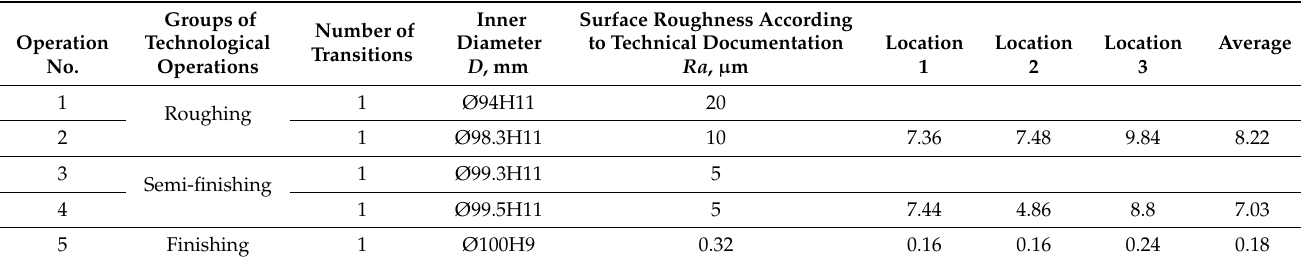
Table 3. Structure of technological operations for manufacturing hydrocylinder liners shown on an example of the KS- 4574.63.900 hydrocylinder for releasing the KTA-25 truck crane beam. Operation